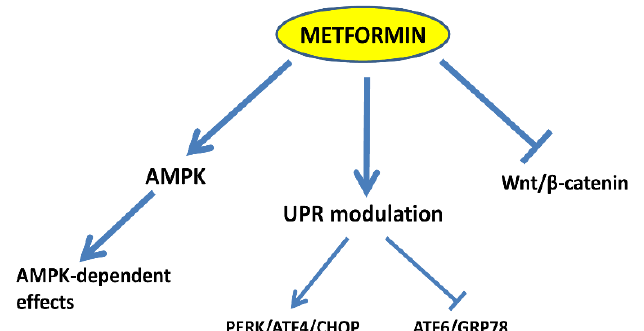
Figure 7. Scheme summarizing the observed mechanisms affected by metformin in endometrial cancer cells. Besides AMPK activation, metformin modulates the UPR by activating the PERK/ATF4/CHOP axis and inhibiting the ATF6/GRP78 axis. Furthermore, metformin inhibits the Wnt/β-catenin signaling pathway by reducing β-catenin expression. Supplementary Materials: The following are available online at www.mdpi.com/xxx/s1, Figure S1: CC does not affect AKT phosphorylation and GRP78 expression in Ishikawa and AN3CA cells; Figure S2: Metformin decreases β-catenin expression in both cytosolic and nuclear extracts of Ishikawa and AN3CA cells.